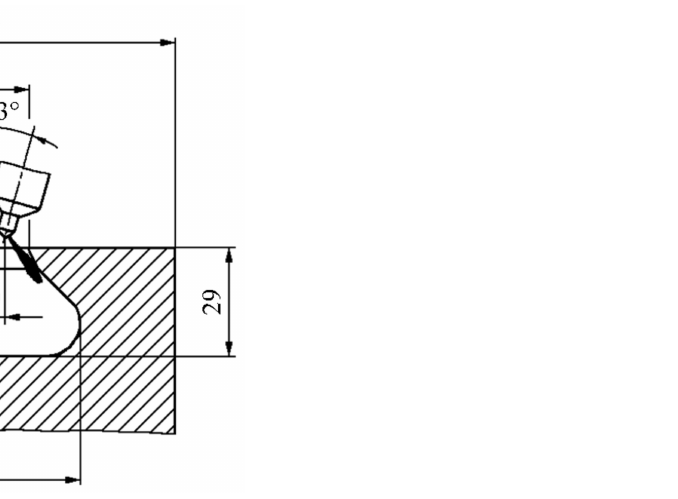
Figure 2. Schematic of the combustion chamber and the injector arrangement of the diesel engine D-245. (Length unit is mm.).